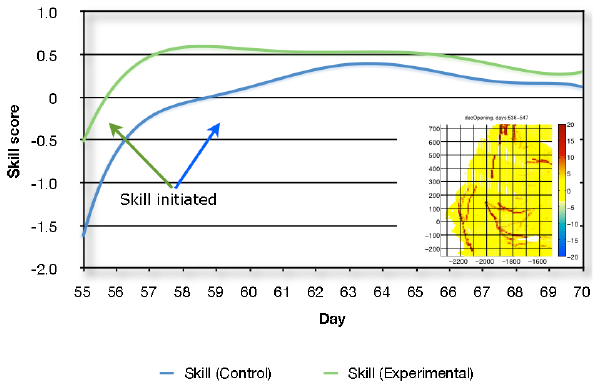
Fig. 2. Skill score (against persistence of observed field shown in insert) evolution of the control and experimental simulations. A 1- step DA algorithm was implemented on day 54 (23 February 2004) to the experimental run, whereby the ice model state was updated by changing material properties based on agreement of lower dimen- sional features deduced from RGPS data processed to show regions of high deformation (insert). Days are Julian days of